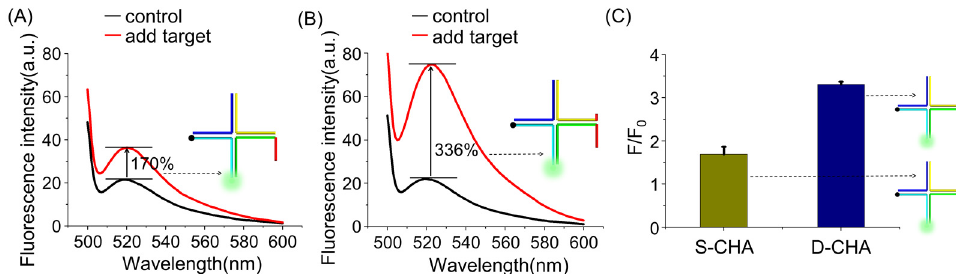
Figure 3. The assay performance of S-CHA-( A ) and D-CHA-( B ) based system. The red line and black line denote the fluorescence spectra of the system in the presence and absence of the target, respectively. ( C ) Comparative evaluation of the signal-to-noise ratio (F/F0) of the two systems for miRNA160D detection. F0 and F represent the signal in the absence and presence of target miR160, respectively. The concentration of HP1, HP2, HP3, HP4, and target are 250 nM, 250 nM, 250 nM, 250 nM, and 125 nM, respectively. The error bars represent means ± SD ( n = 3).